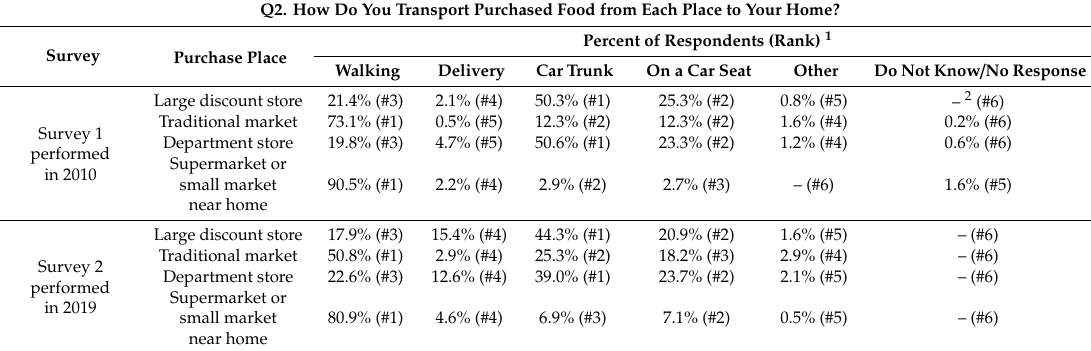
Table 2. Methods for transporting food from each purchase place to consumers’ homes.